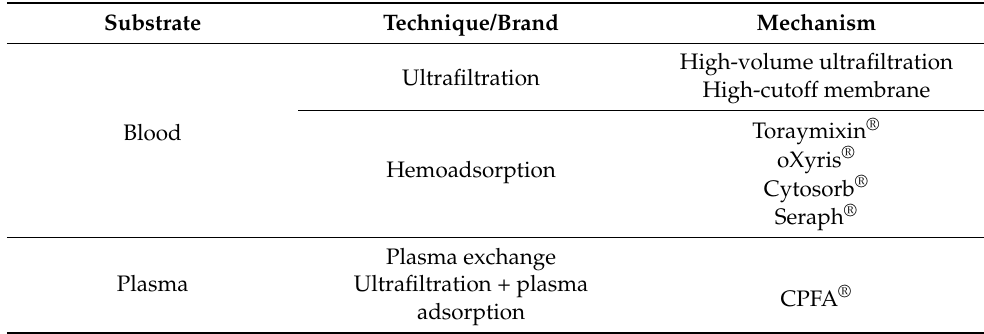
Table 1. Techniques used in BP. Legend: CPFA ® : coupled plasma filtration and adsorption.